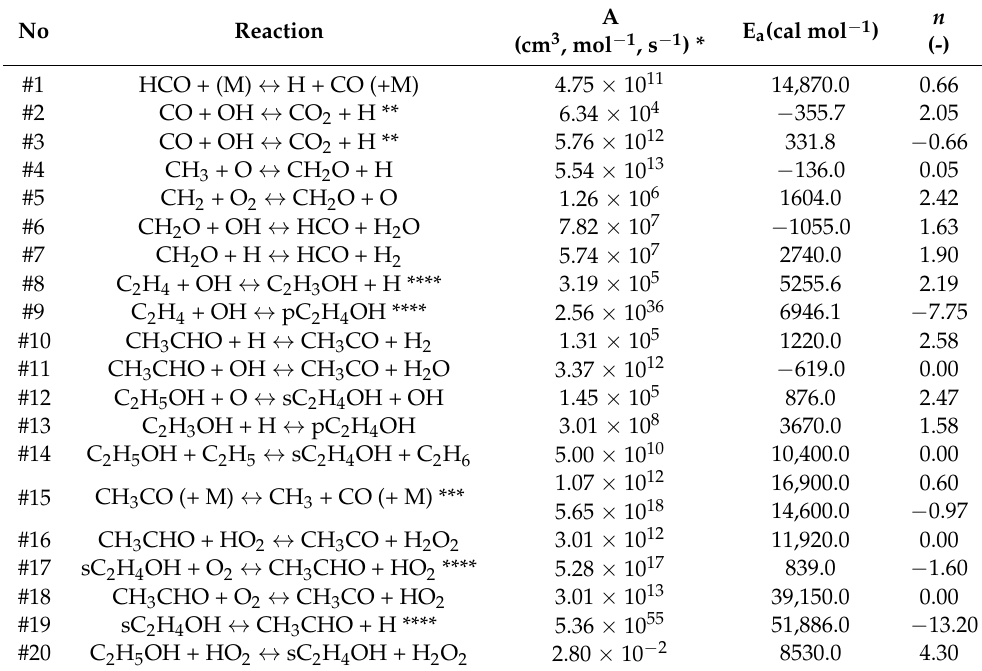
Table 3. Reduced mechanism for ethanol as obtained in this work and implemented in CFD.